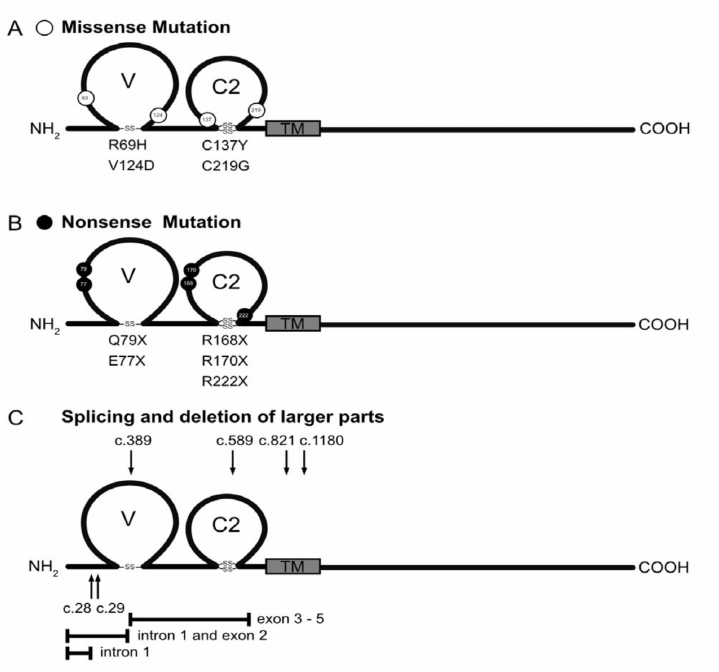
Figure 1. Overview of mutations in the human CLMP gene that coincide with CSBS. Depicted here are schematic representations of CLMP that show the localization of ( A ) missense mutations, ( B ) nonsense and frameshift mutations, and ( C ) mutations leading to splicing errors and deletions of larger parts of the gene. Numbering starts with position 1 at the amino-terminal methionine of the unprocessed polypeptide. The single letter code for amino acids is used, with “X” indicating translation stop. All frameshift mutations lead to the introduction of novel amino acid residues before the premature translational stop. Splicing mutations involve intronic sequences and therefore their positions are only roughly indicated by arrows above and below the schematic representation of CLMP. Their precise effect on the protein structure may vary and should be tested experimentally. The deletion of larger parts of the CLMP gene are indicated by bars below the scheme (deletion of exon 3 to 5; deletion in intron 1 together with exon 2 or deletion in intron 1). Different sizes of deletions, encompassing exons 3 to 5, of 3164 bp, 1629 bp, or 4227 bp have been